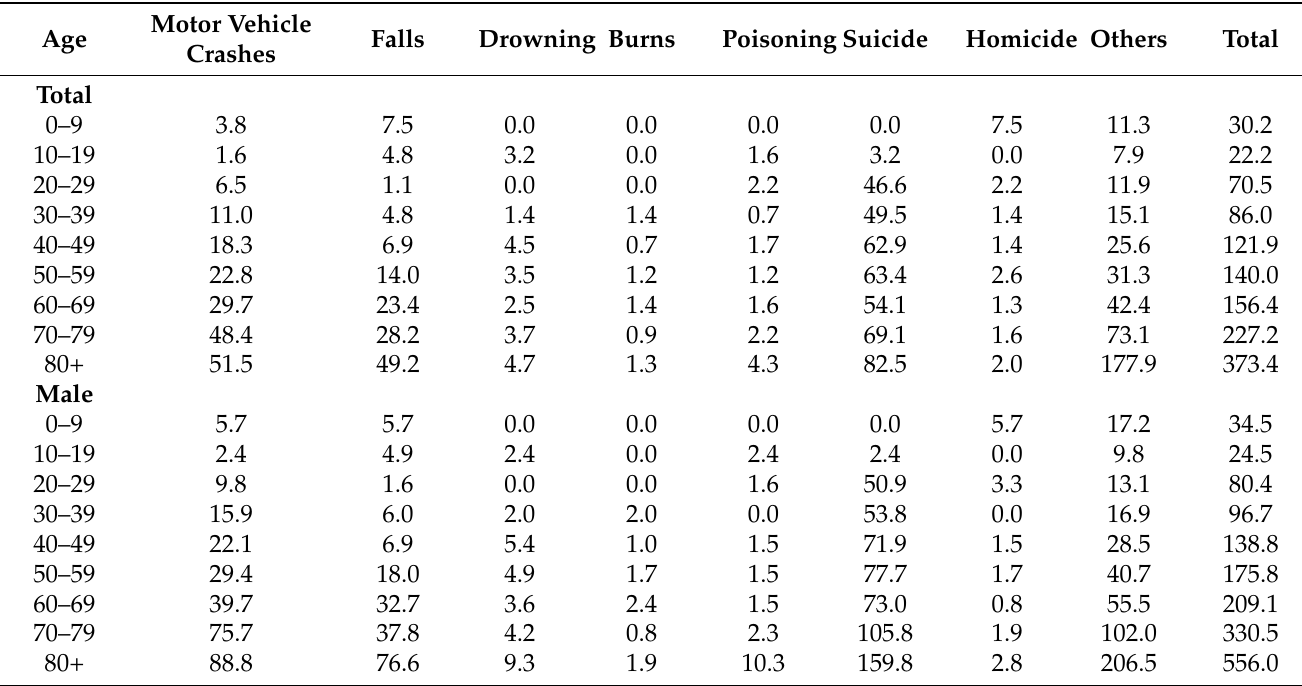
Figure 1. Trends of mortality rate due to external causes of injury (ECIs) (per 100,000) in South Korea, 2008–2017. The blue line is people with disabilities, and the red line is general populations. Table 2. Crude mortality rate due to external causes of injury (ECIs) by sex and age of persons with disabilities, 2017 (Unit: per 100,000